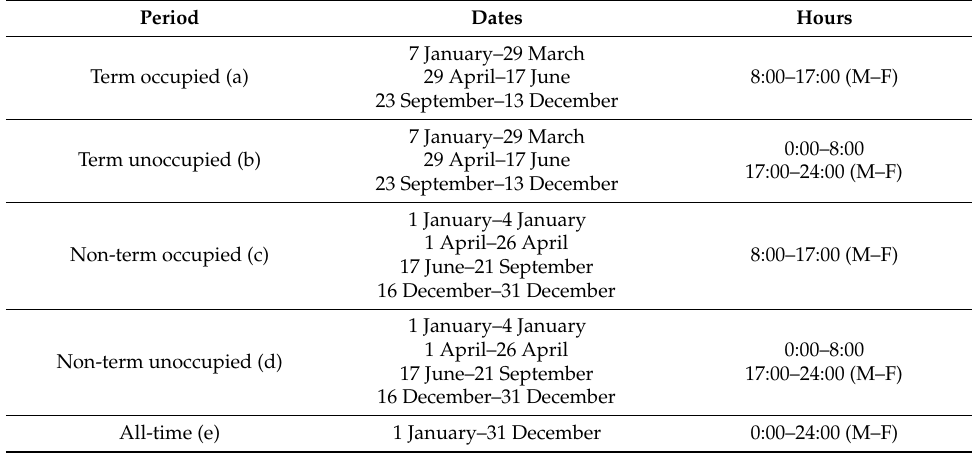
Table 2. Details of segmented